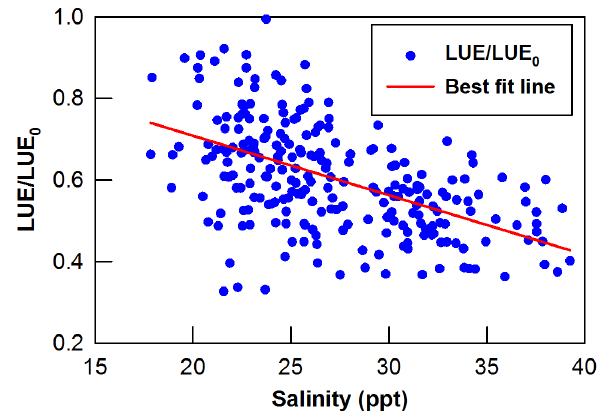
Fig. 6. Eight-day average light use efficiency (LUE) normalized by the extrapolated LUE, LUE 0 at a salinity value of 0 ppt during 2004-2005 and November 2006 to December 2011. The best fit line (slope = -0.0146 and intercept = 1.0) represents the predicted decline in fractional LUE with 8-day average salinity beginning at a value of 1.0 at zero salinity .